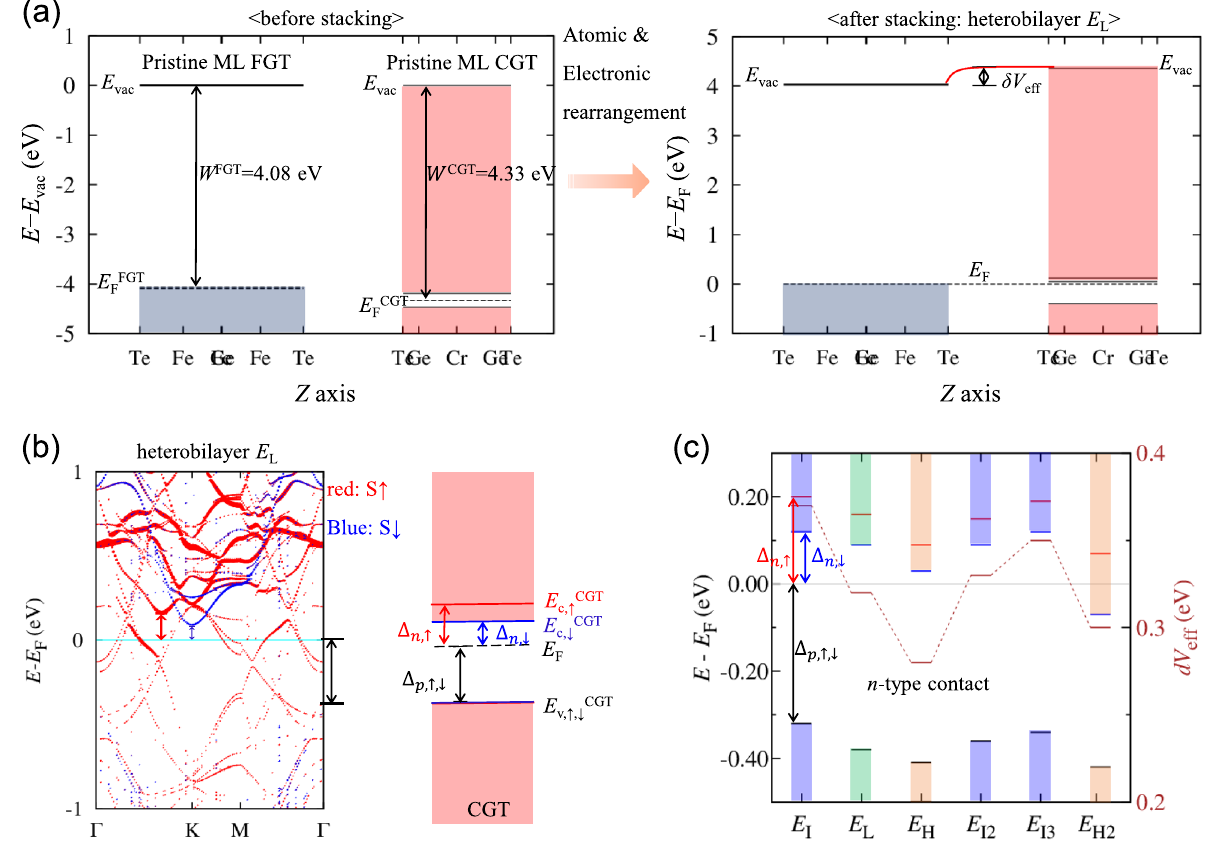
Figure 5. ( a ) Relative band alignment of the FGT and CGT layers before (left panel) and after stacking (right panel). Right after stacking, atomic and electronic rearrangements occur. E vac and E F denote the vacuum and Fermi levels, respectively. The effective potential difference, δ V eff , is noted at the interface. ( b ) Band structures for E L (left panel) and schematic band edges of the CGT layer in the heterobilayer (right panel). The spin-up (red) and spin-down (blue) bands are projected onto a Cr atom; the color intensity corresponds to the projection magnitude. The n -type ( (cid:31) n ), and p -type ( (cid:31) p ) band edges are indicated by colored arrows. ( c ) Band edges of the CGT layer and effective potential difference, δ V eff , depending on the stacked structures. d inter (Å) (cid:31) n , ↑